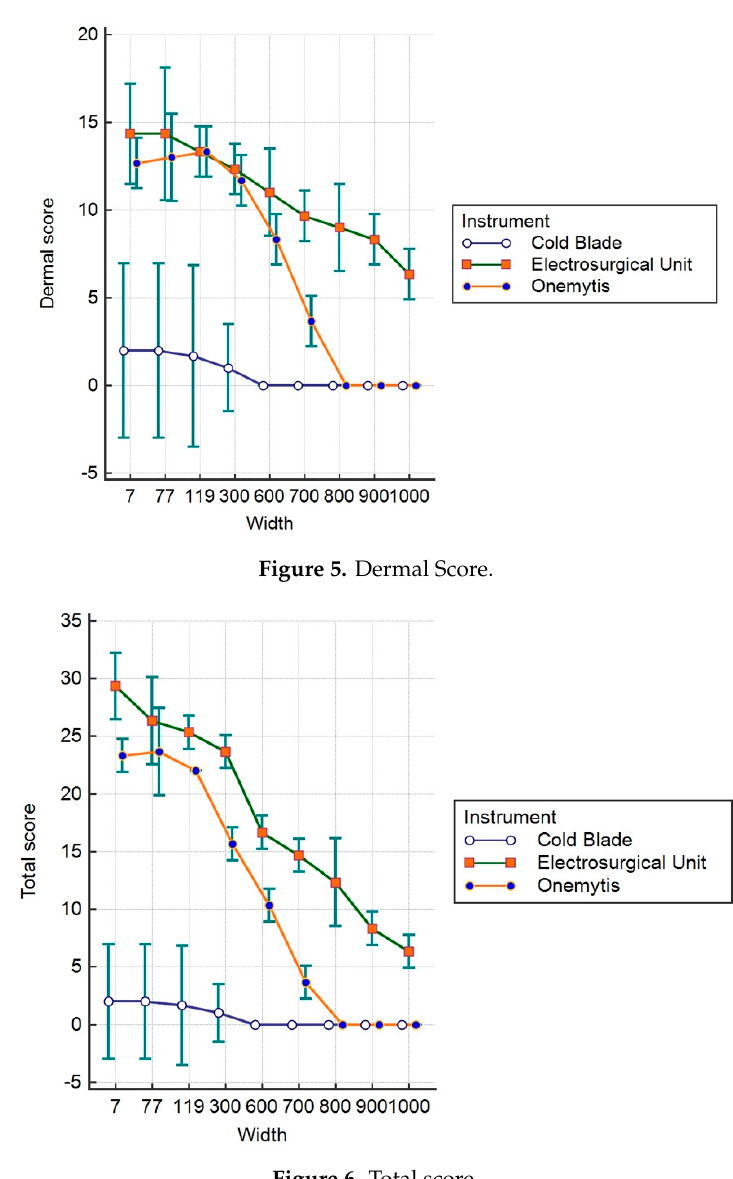
Figure 6. Total Figure 6. Total score.